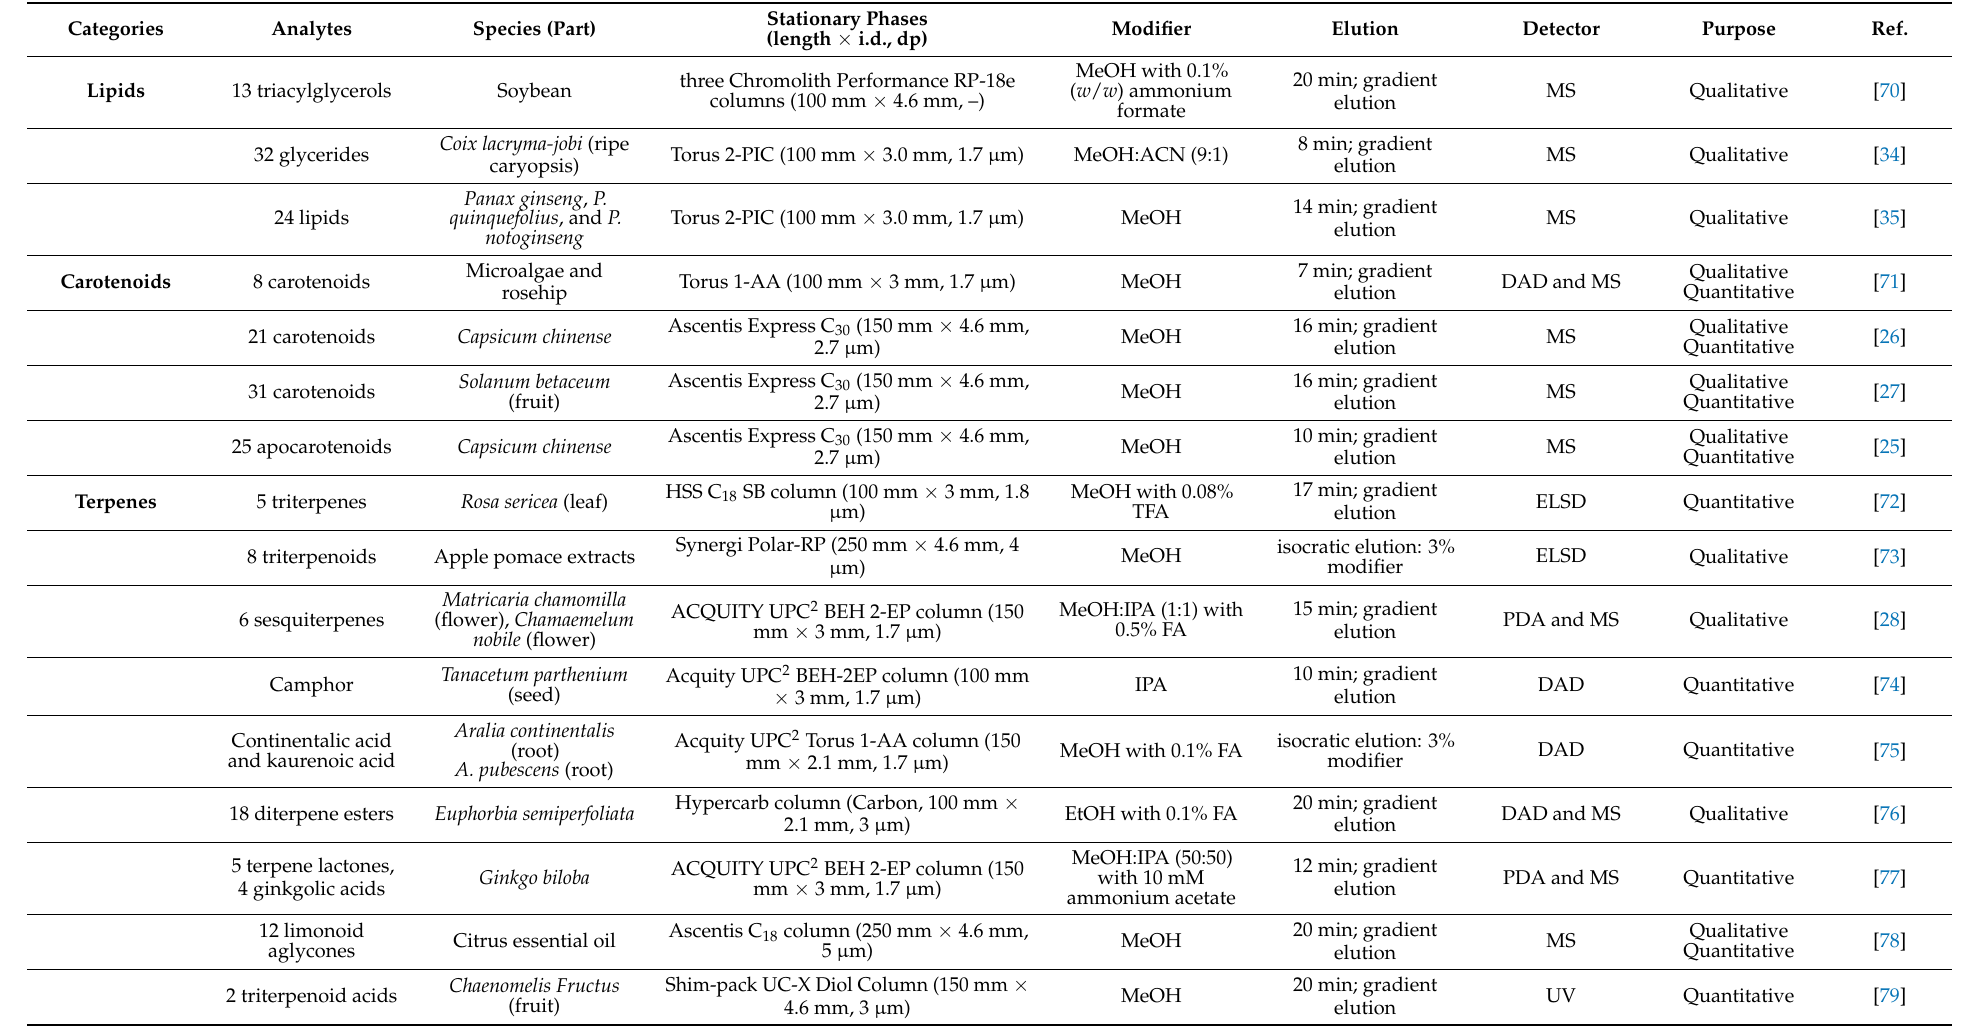
Table 1. Application of SFC in the analysis of natural